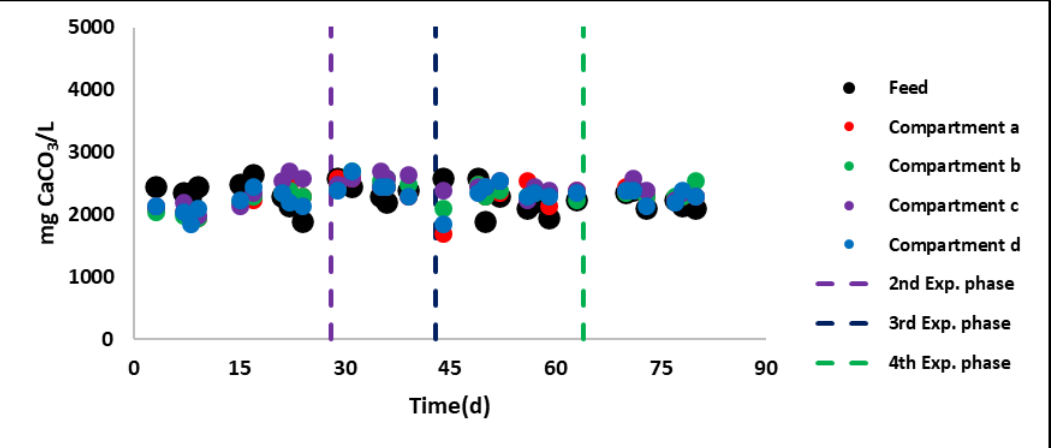
Figure 15 . Daily pH values of the feedstock and the reactor compartments. Figure 16 . Daily total alkalinity value of the feedstock and the reactor ’ s compartments. Figure 16. Daily total alkalinity value of the feedstock and the reactor’s